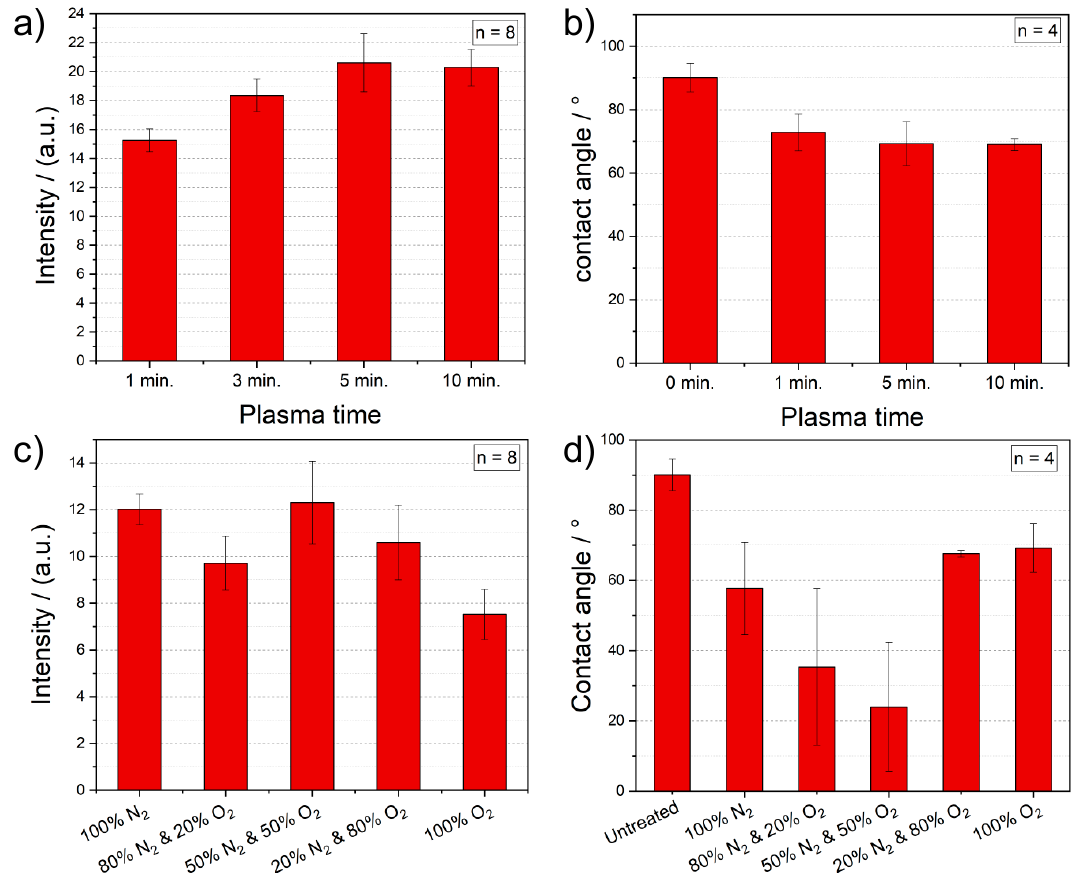
Figure 4. ( a ) Measured intensities of immobilized gold NP labelled antibody on plasma treated PMMA foils with different process times (100% O 2 , 1000 W, 80 °C). ( b ) Contact angle measurements of plasma activated PMMA foils with different time parameters (100% O 2 , 1000 W, 80 °C). ( c ) Optical intensity measurement of the antibody immobilization on plasma treated PMMA foils with different gas parameters for O 2 and N 2 (3 min, 1000 W, 80 °C). (d) Contact angle measurements of plasma activated PMMA foils with different gas parameters for O 2 and N 2 (5 min, 1000 W, 80 °C).